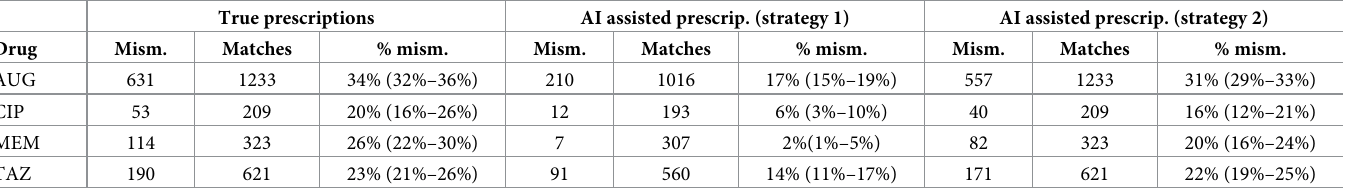
Table 5. Mismatched therapies in true prescriptions (left columns) and prescriptions selected by the AI (center and right columns for strategy 1 and 2, respectively). In these two strategies, the episodes most likely to report resistance to an antimicrobial agent are assumed to be left untreated (thus lowering the total exposure to the drug) or treated with a different drug. For all drugs considered, the percentage of mismatches is significantly lower with these two strategies than in true prescriptions. Mism. = mismatched. True prescriptions AI assisted prescrip. (strategy 1) AI assisted prescrip. (strategy 2) Drug Mism. Matches % mism. Mism. Matches % mism. Mism. Matches %